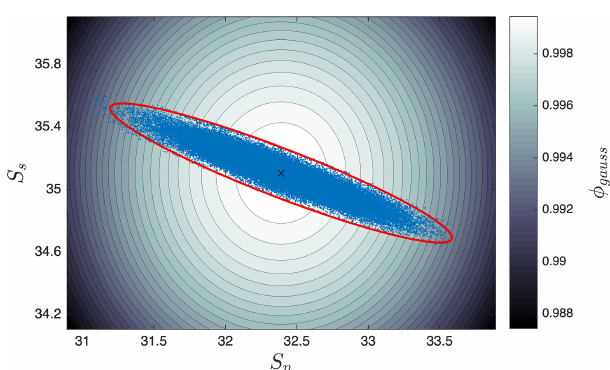
Figure 9. Level sets of the score function φ gauss in proximity to the collapsed equilibrium state X B of the system in Castellana et al. (2019), projected onto the plane identified by the variables S n and S s (respectively, the salinity of the northern box and the one of the southern box in the model). A trajectory of the system, initiated in the collapsed state, has been projected onto the same plane (blue circles). The red ellipse is the two-dimensional projection of the covariance ellipsoid constructed by using the matrix C S fidence level of 0.95; 98% of the points comprising the trajectory are inside the